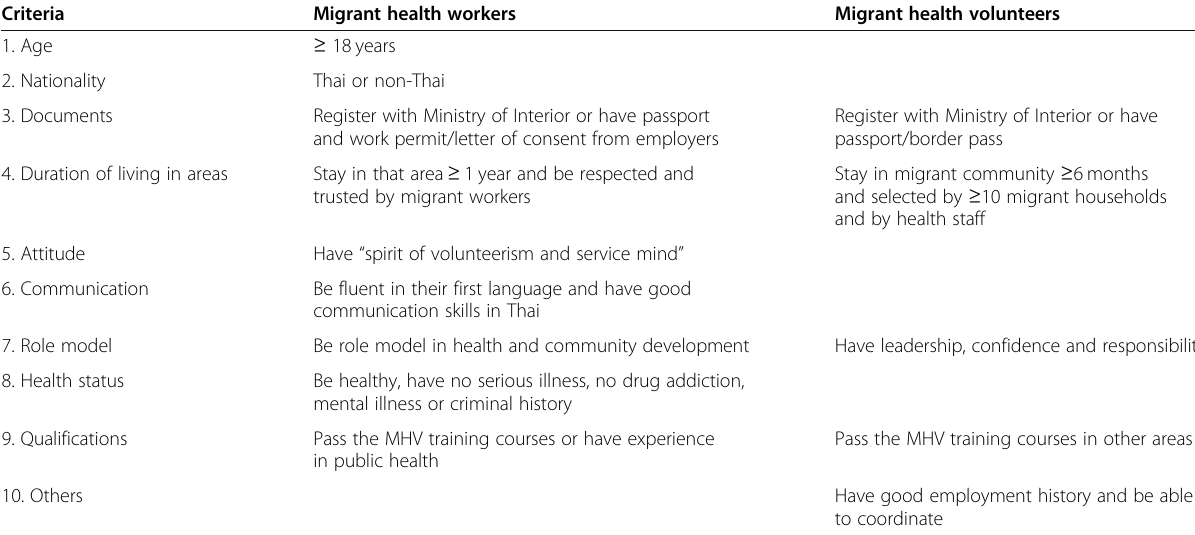
Table 3 Recruitment criteria of MHWs and MHVs